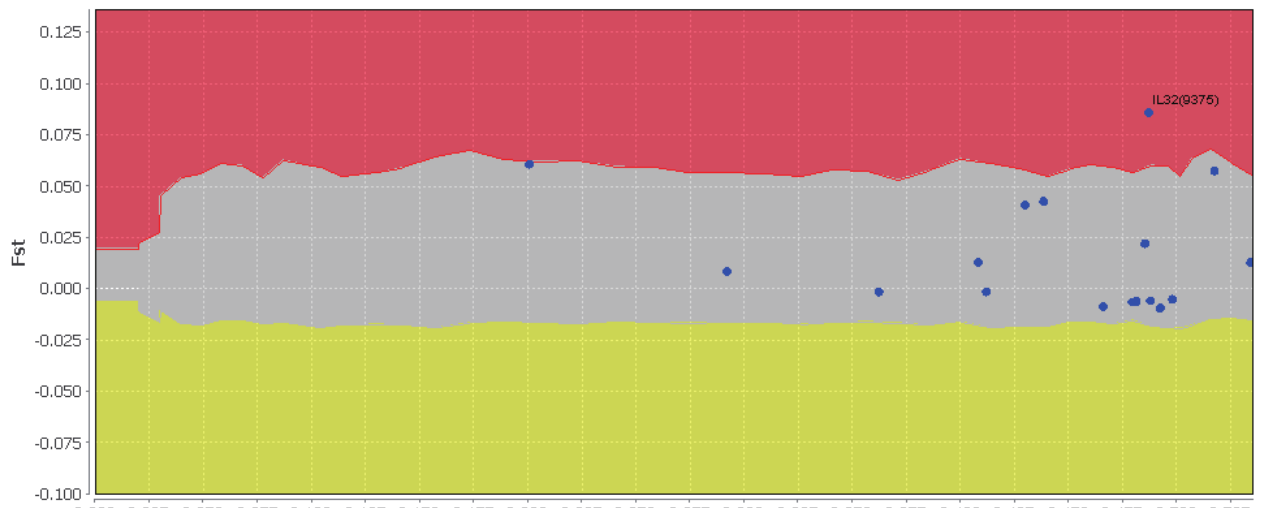
Figure 1. Candidate gene interleukin-32 under positive selection keeping the 95% confidence interval. F